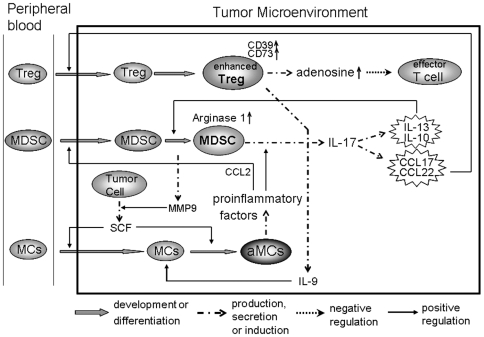
A model of the closed loop among mast cells, MDSCs and Treg cells in tumor microenvironment.Under the guidance of SCF/c-kit signaling, mast cells migrate to and are activated in tumor microenvironment; the activated mast cells release a panel of factors, leading to CCL2 production and IL-17 upregulation in MDSCs; CCL2 signaling recruits more MDSCs, leading to more IL-17 production; IL-17 strengthens tumor inflammatory microenvironment, leading to the upregulation of IL-9, IL-10, IL-13, CCL17, CCL22, CD39 and CD73; IL-10 and IL-13 induce arginase 1 expression by MDSCs; CCL17 and CCL22 attract the migration of Treg cells; CD39 and CD73 enhance suppressor function of Treg cells; IL-9 produced by Treg cells maintains the survival of mast cells; MDSCs release active MMP9, through which soluble SCF is generated, thus further facilitating the migration and activation of mast cells.